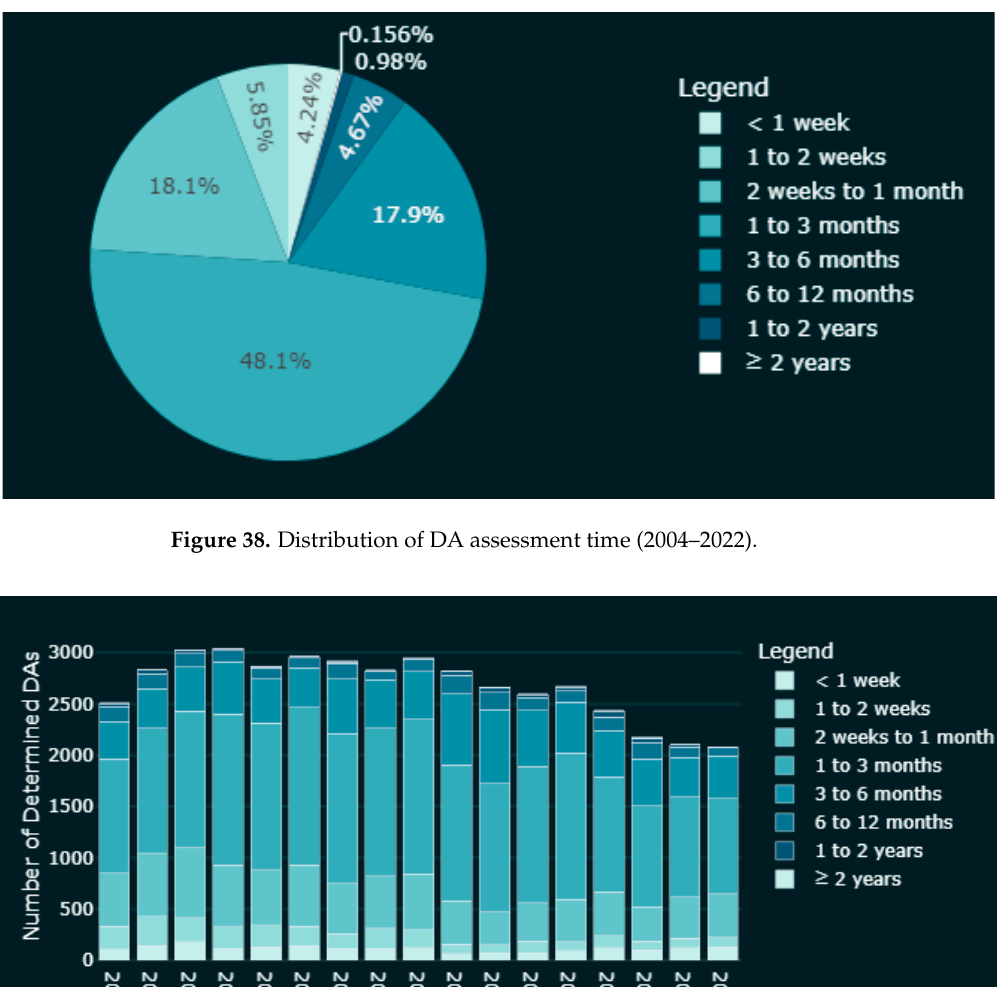
Figure 41. Proportion of different types of determination (2004–2022). Figure 42. Annual median assessment time by decision type (2004–2022).